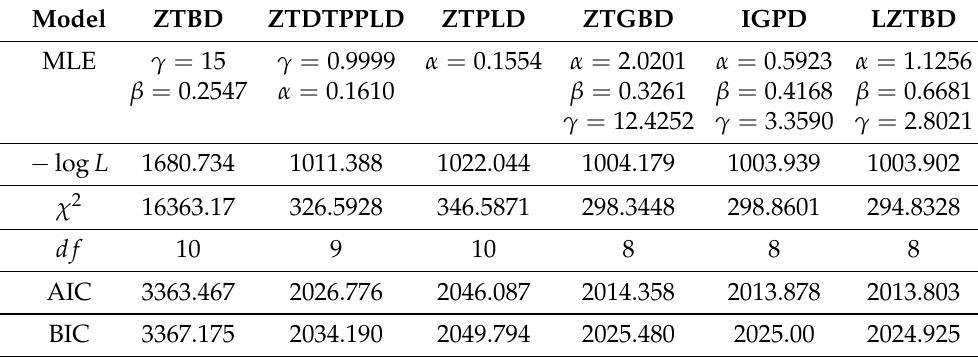
Table 14. Maximum likelihood estimates (MLEs), model adequacy measures, and χ 2 value for the Ethiopia data